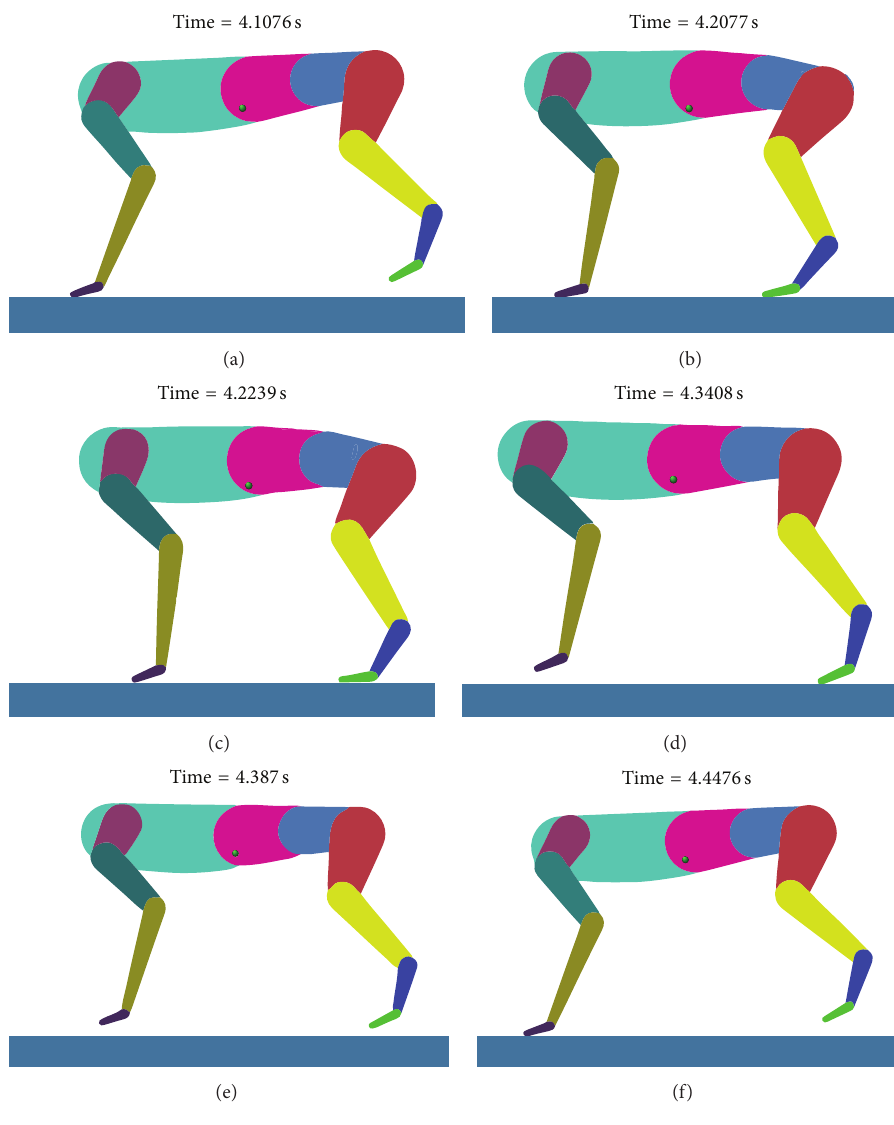
Figure 7: Screen captures of the